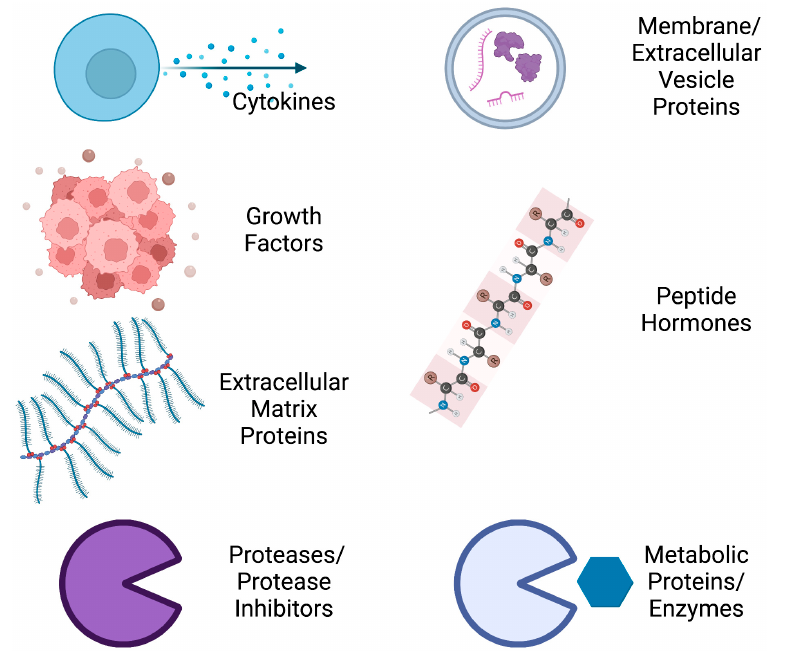
Figure 1. Proteins of the TNBC secretome. A large variety of functional proteins are secreted from TNBC cells and tumors (Created with BioRender.com). TNBC cells and tumors (Created with